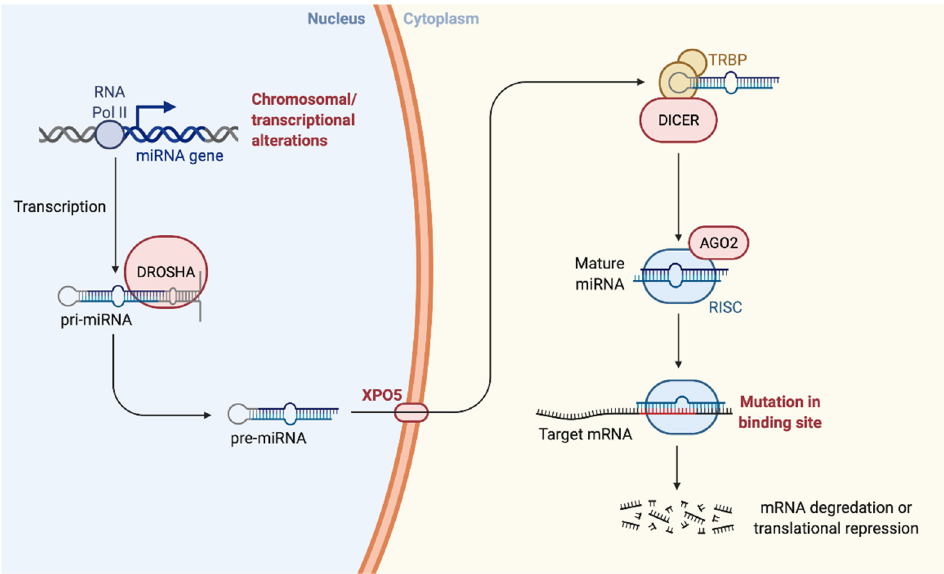
Figure 1. Biogenesis of the microRNA. “Created with BioRender.com”.